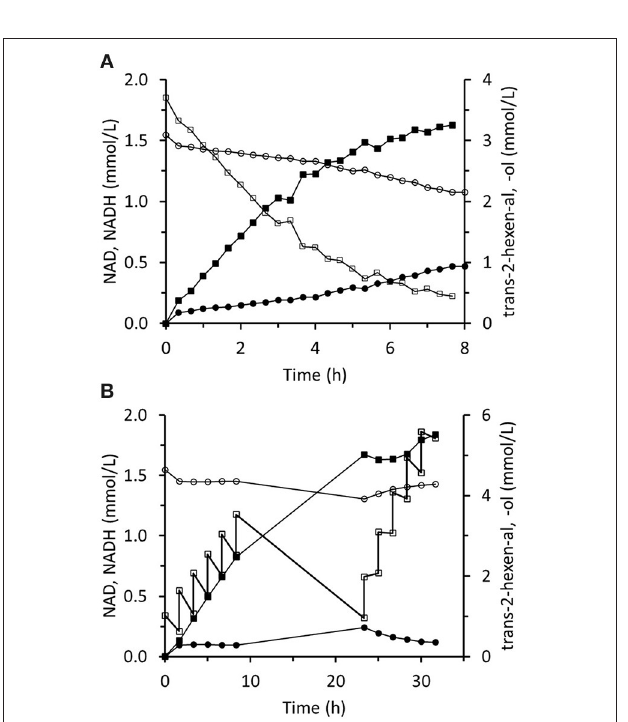
FIGURE 11 | Reaction course in the infinite recycling system with increased FDH amount under batch operation (A) and fed-batch operation (B) . (cid:4) - trans -2-hexenol; (cid:3) - trans -2-hexenal; • - NADH; ◦ - NAD.